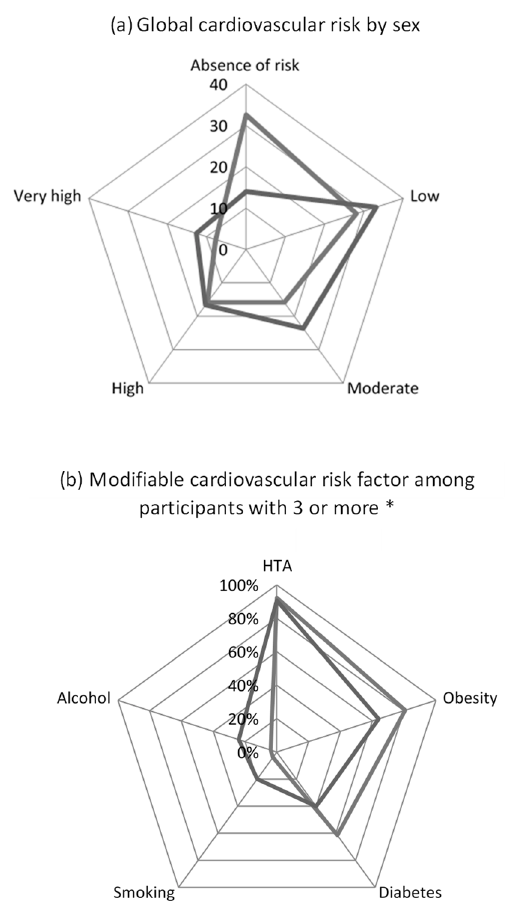
Figure 2. Modifiable cardiovascular risk factors among Novembre Vert 2018 participants with three or more risk factors by sex. * Among: age, HBP, obesity, diabetes, daily alcohol consumption and smoking (HBP = High blood pressure; RF = risk factor). Legend ( a ) in dark grey women (n = 221) and light grey men (n = 356), ( b ) in dark grey women (n = 26) and light grey men (n = 75). Table 2. Cardiovascular risk factors of the Novembre Vert 2018 participants by